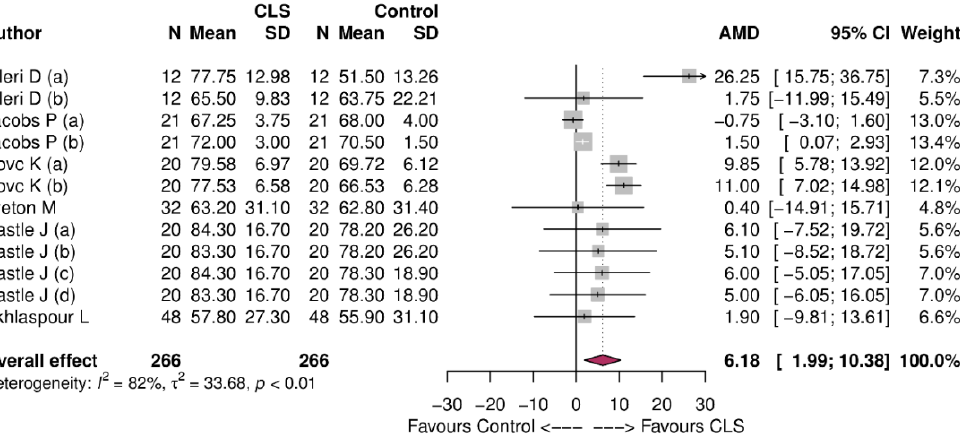
Figure 3. Forest plot of meta-analysis showing the overall effect of control vs. CLS for time in range during physical exer- cise.